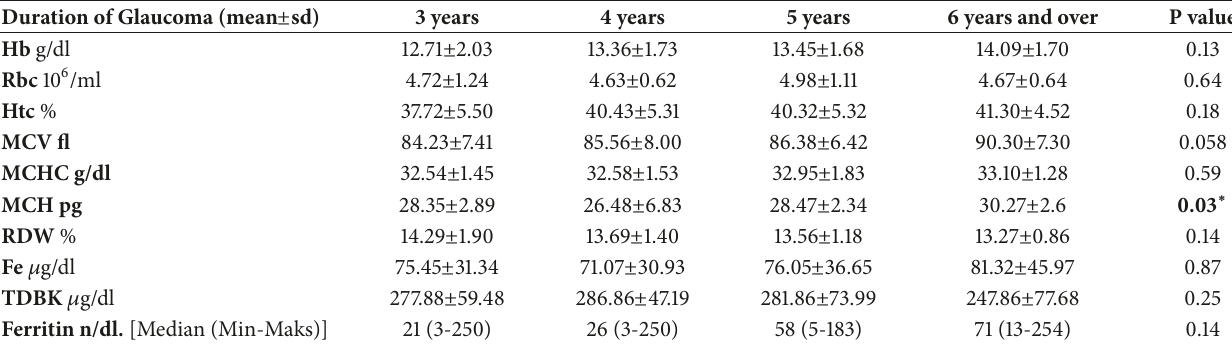
Table 4: Comparison of the hemogram, iron, TIBC, and ferritin values according to the duration of glaucoma in Group 2. Duration of Glaucoma (mean ± sd) 3 years Hb g/dl